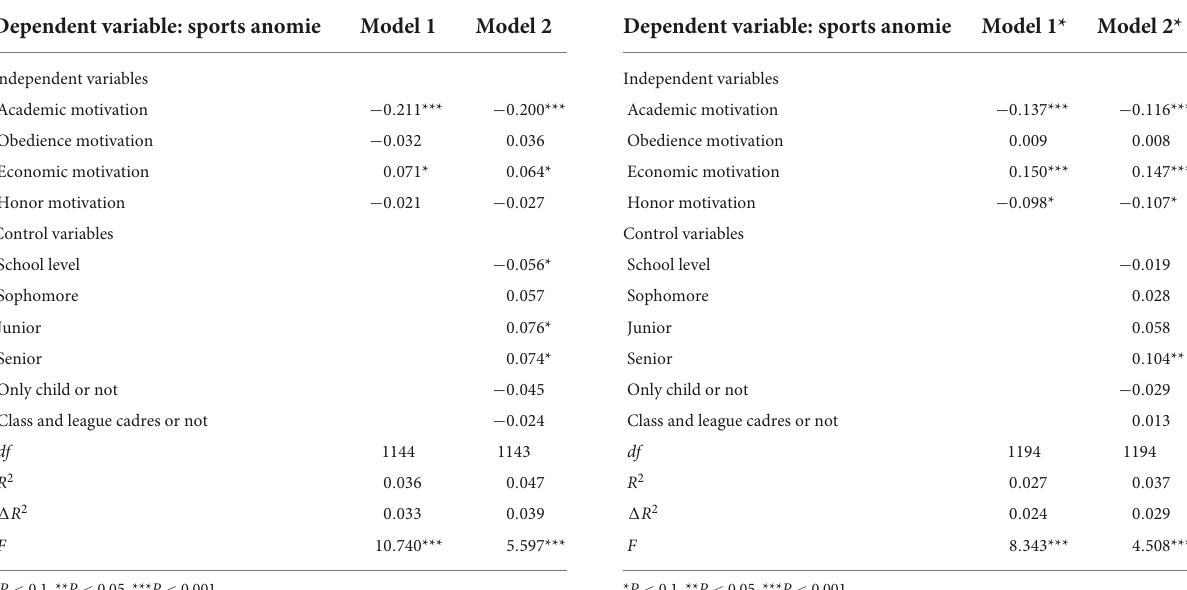
TABLE 4 Multiple linear regression of sports anomie behavior of female college